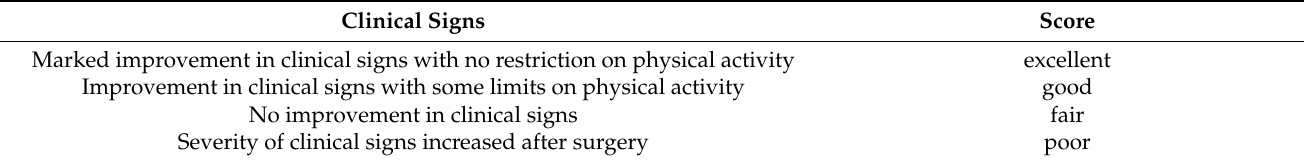
Table 1. Clinical findings and respective scores of the dogs at the time of